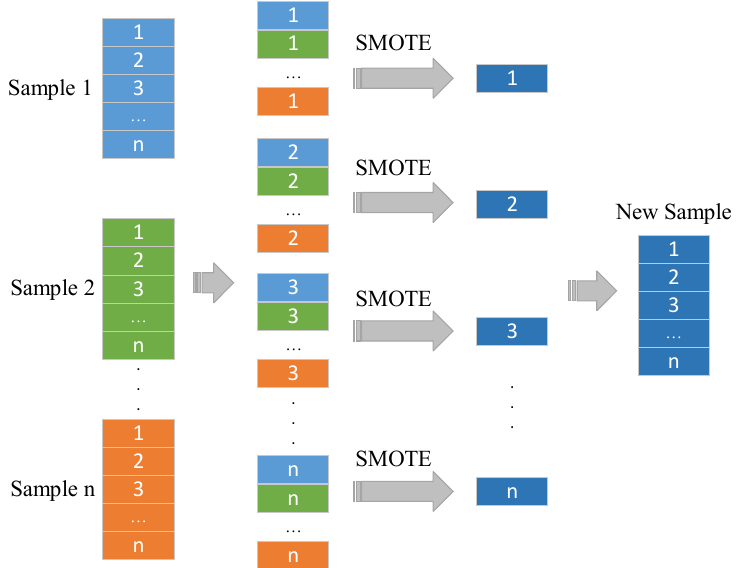
Figure 3. Two-dimensional matrix SMOTE algorithm.